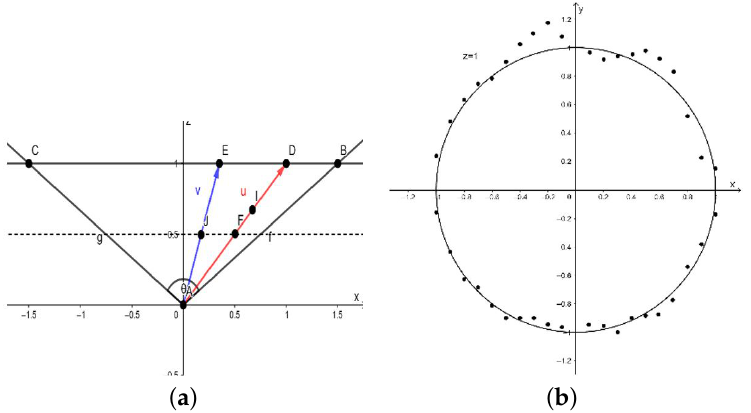
Figure 8. ( a ) Positions of objects in AR space ( b ) Measurement positions expressed on the x − y plane. P i in Equation (1) means a point on the z = 1 plane. Here, P c is the center of each point, which is the average of the sum of the coordinates of p i . Each point P i is measured at regular angular intervals, and all are placed at the position of z = 1. The vertical component, p iy is weighted so that it can react relatively insensitively in the vicinity of the center and sensitively at large